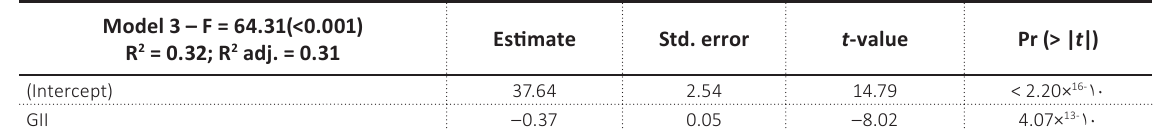
Table 5. Regression analysis – model